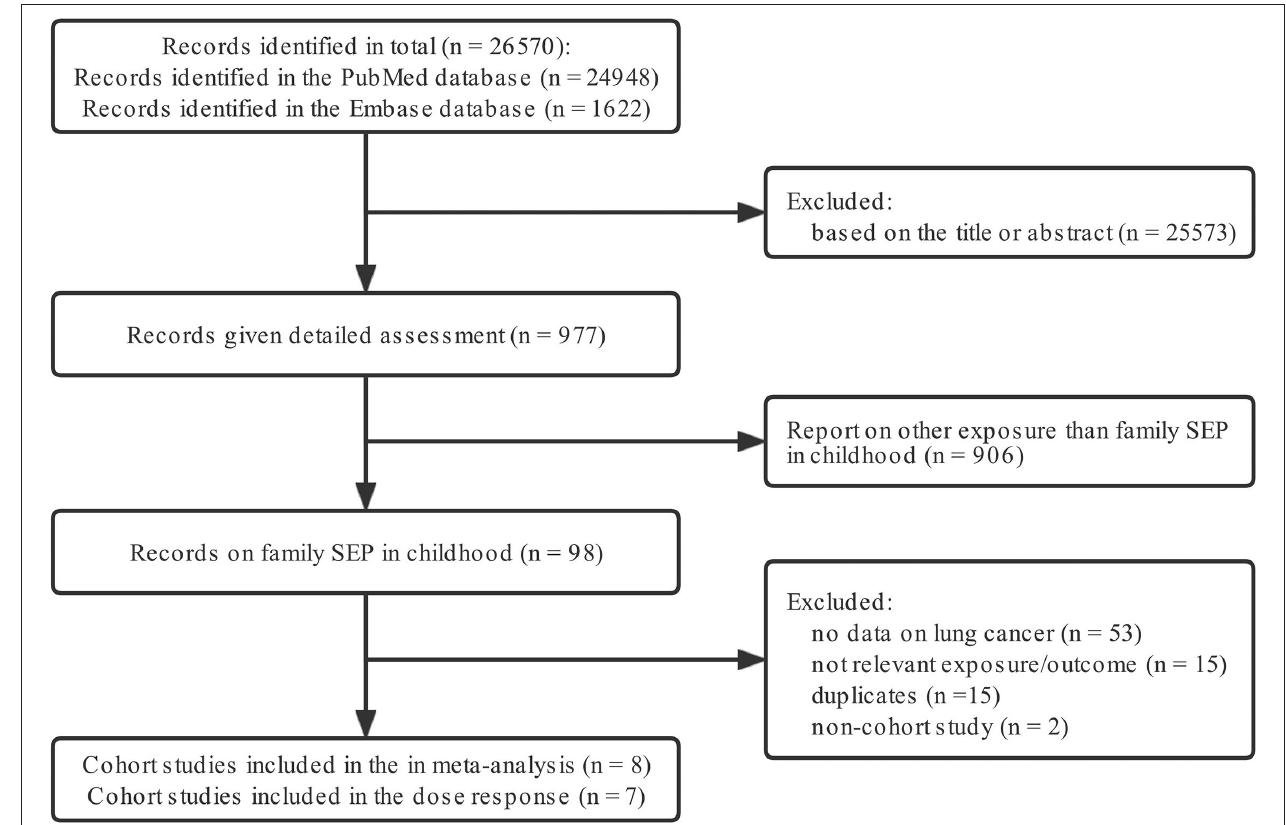
FIGURE 1 | Flow diagram detailing the search strategy and identification of studies used in